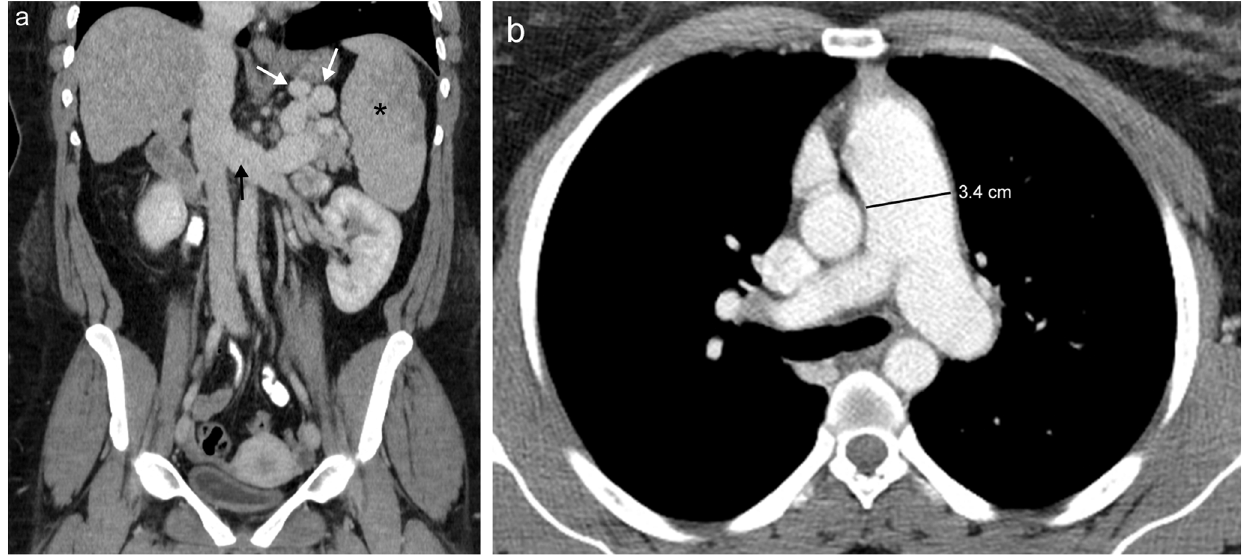
Fig. 6 Pulmonary hypertension in a patient with liver disease. a Coronal contrast-enhanced CT image shows sequela of portal hypertension sec- ondary to cirrhotic liver morphology with splenomegaly (*), enlarged splenorenal collateral vessels ( white arrows ) and enlarged left renal vein